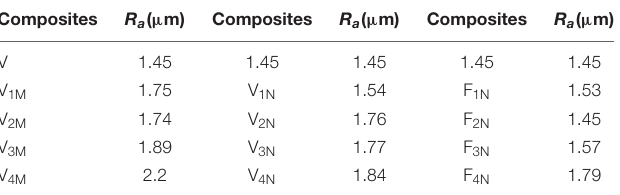
TABLE 4 | Average roughness of worn composite disks.